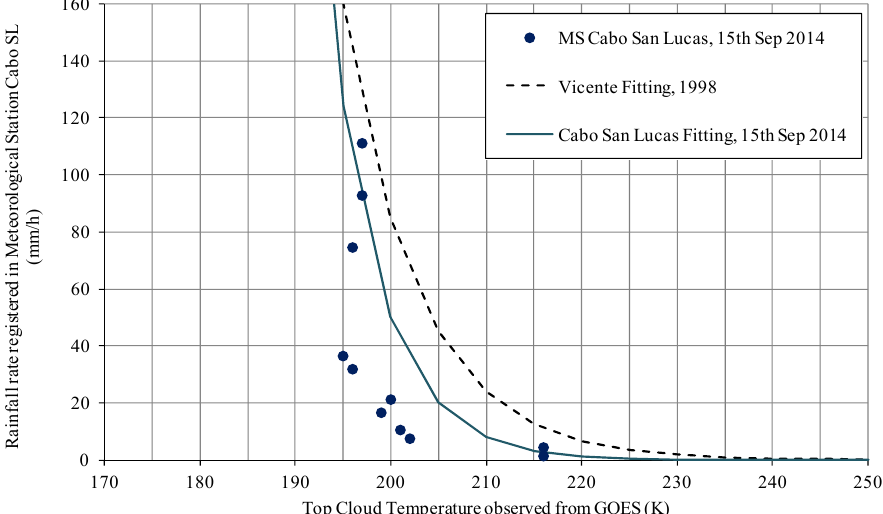
Figure 3. The relationship (R 2 = 0.67) between rainfall intensity from MGS Alvarado on 9 August 2012 and the temperature of cloud tops from the satellite image on the same date of Hurricane Ernesto.